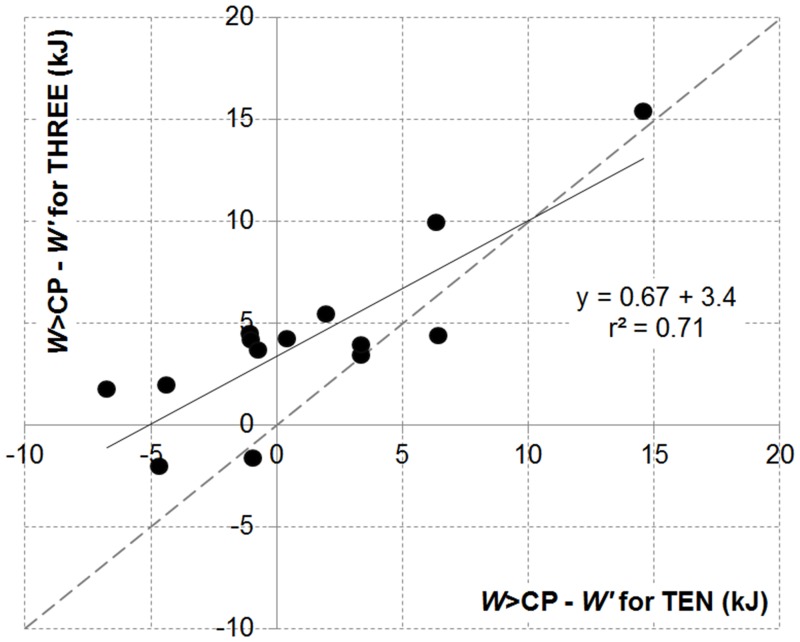
Scatter plots representing the differences between W>CP and W’ for THREE against TEN.The dash line represents the line of identity.